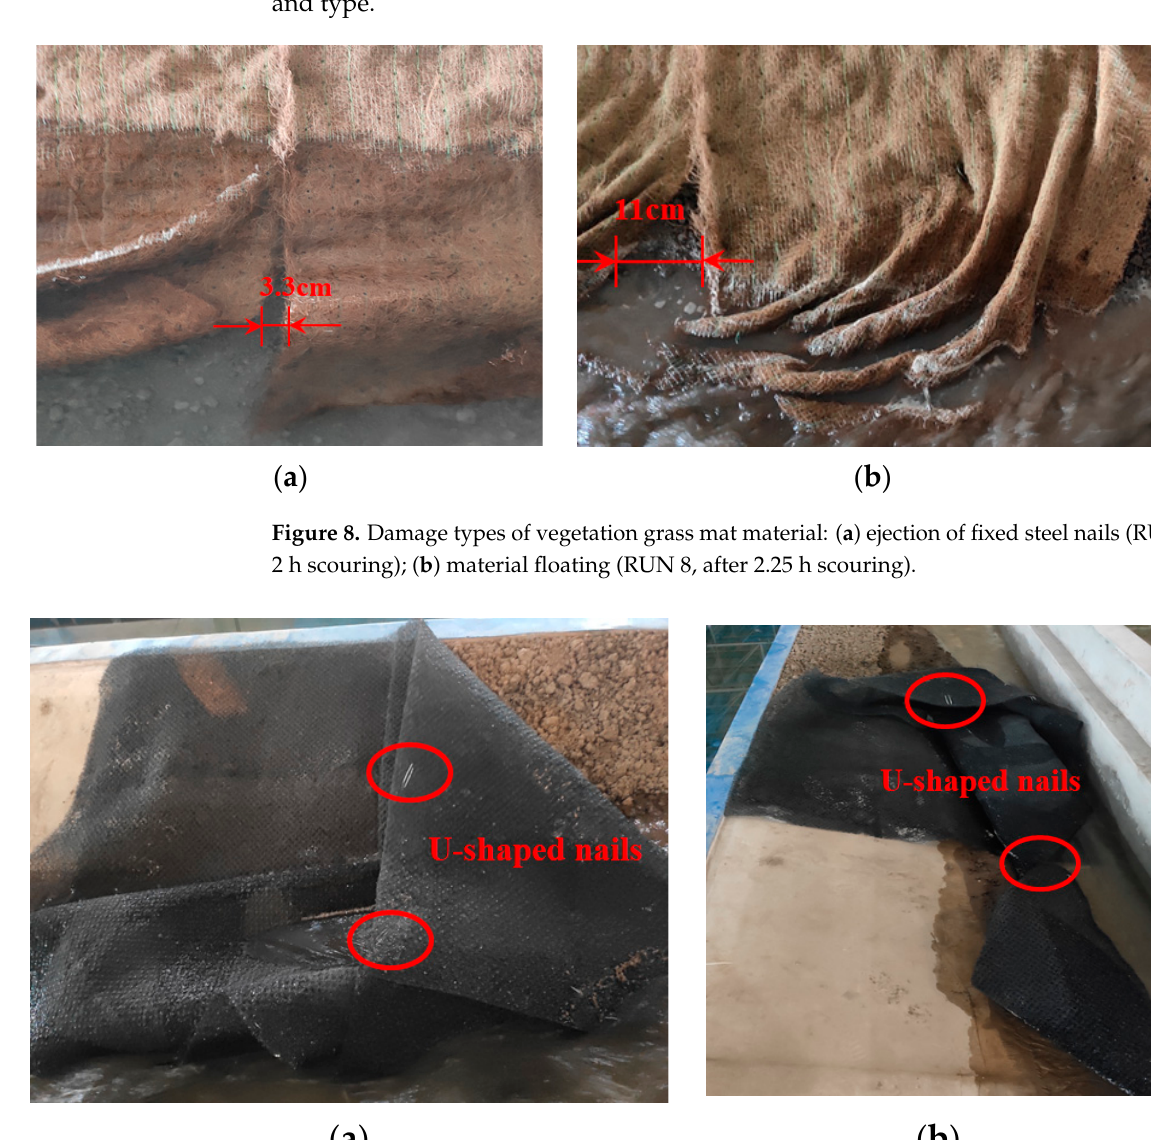
( b ) Figure 7. Soil erosion under different slope protection conditions: ( a ) initial stage of soil erosion at the slope foot (RUN 12, after 1 h scouring); ( b ) erosion shape of soil at the slope foot (RUN 9, after 40 h scouring). 4. Discussion 4.1. Anti-Scour Properties of Mat Materials for Slope Protection